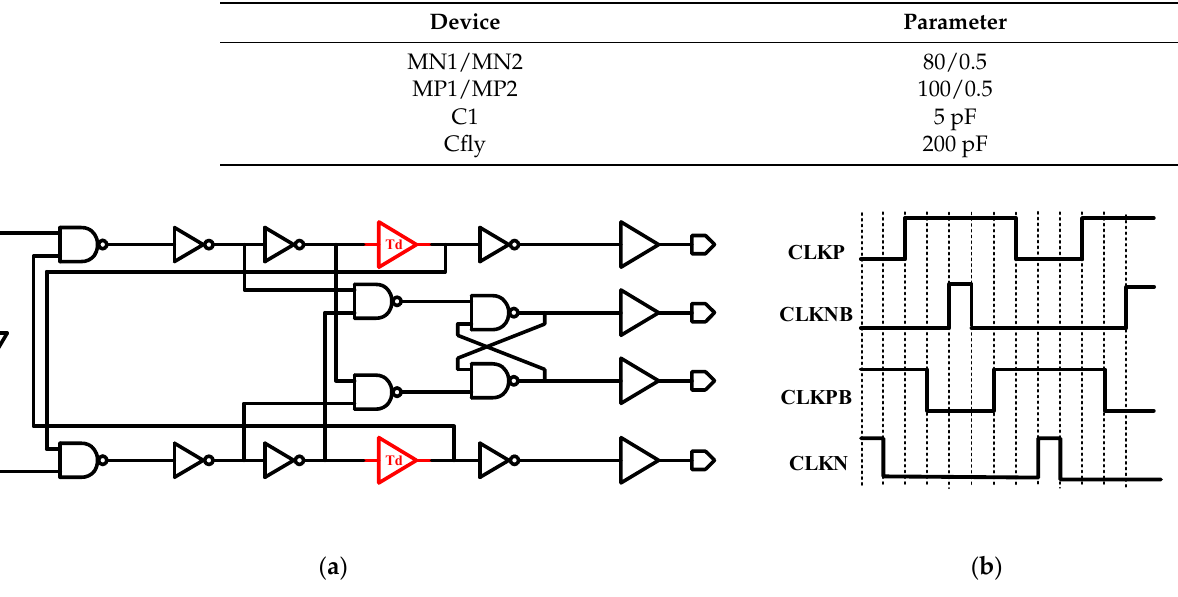
Figure 8. ( a ) Four-phase clock generation circuit; ( b ) Four-phase clock logic diagram.